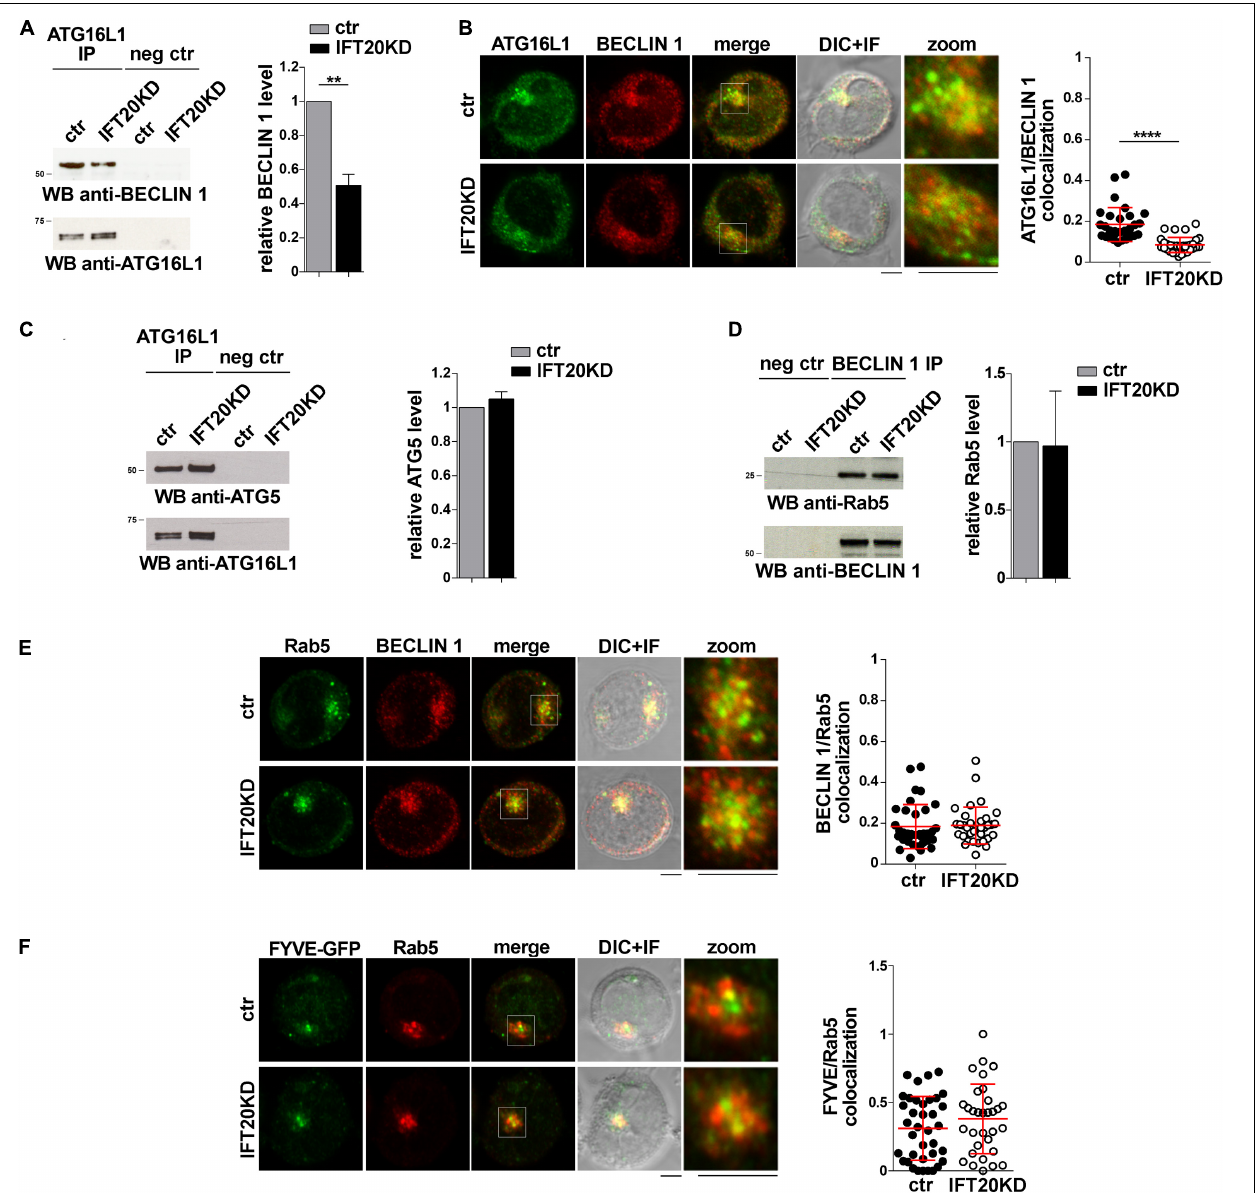
FIGURE 5 | IFT20 recruits ATG16L1 to early endosomes tagged for autophagosome formation. (A) Immunoblot analysis with BECLIN 1 antibodies of ATG16L1-specific immunoprecipitates from lysates of control and IFT20KD Jurkat cells. Preclearing controls are included in each blot (neg ctr). Tested proteins show comparable expression in total cell lysate from ctr and IFT20KD Jurkat cells ( Supplementary Figures 3A,C ). The migration of molecular mass markers is indicated. The quantification of the relative protein expression normalized to ATG16L1 (mean fold ± SD; ctr value = 1) is reported for each blot ( n = 3; mean ± SD; Student’s t -test). (B) Quantification (using Mander’s coefficient) of the weighted colocalization of ATG16L1 with BECLIN 1 in medial confocal sections of control and IFT20KD Jurkat cells (mean ± SD; ≥ 30 cells/line; n = 3; Mann–Whitney test). Representative images (medial optical sections and overlay DIC + IF) are shown. Scale bar: 5 µ m. (C) Immunoblot analysis with ATG5 antibodies of ATG16L1-specific immunoprecipitates from lysates of control and IFT20KD Jurkat cells. Preclearing controls are included in each blot (neg ctr). Tested proteins show comparable expression in total cell lysate from ctr and IFT20KD Jurkat cells ( Supplementary Figures 3A,D ). The migration of molecular mass markers is indicated. The quantification of the relative protein expression normalized to ATG16L1 (mean fold ± SD; ctr value = 1) is reported for each blot ( n = 3; mean ± SD). (D) Immunoblot analysis with Rab5 antibodies of BECLIN 1-specific immunoprecipitates from lysates of control and IFT20KD Jurkat cells. Preclearing controls are included in each blot (neg ctr). Tested proteins show comparable expression in total cell lysate from ctr and IFT20KD Jurkat cells ( Supplementary Figures 3B,C ). The migration of molecular mass markers is indicated. The quantification of the relative protein expression normalized to ATG16L1 (mean fold ± SD; ctr value = 1) is reported for each blot ( n = 3; mean ± SD). (E,F) Immunofluorescence analysis of BECLIN 1 and Rab5 (E) or FYVE-GFP and Rab5 (F) in control and IFT20KD Jurkat cells. Representative medial optical sections and overlay of immunofluorescence and DIC images are shown (IF + DIC). Scale bar: 5 µ m. The graphs show the quantification of the weighted colocalization (Mander’s coefficient) of BECLIN 1 (E) or FYVE-GFP (F) and Rab5 in ctr and IFT20KD Jurkat cells (mean ± SD; ≥ 32 cells/line; n = 3; Mann–Whitney test). **** P < 0.0001.